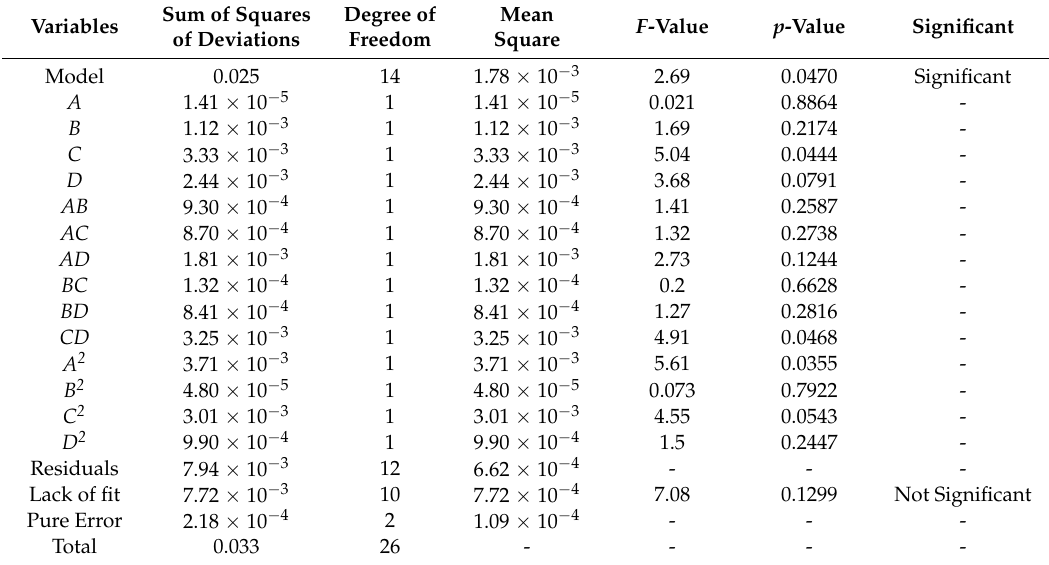
Table 7. Variance analysis results for the damping coefficient